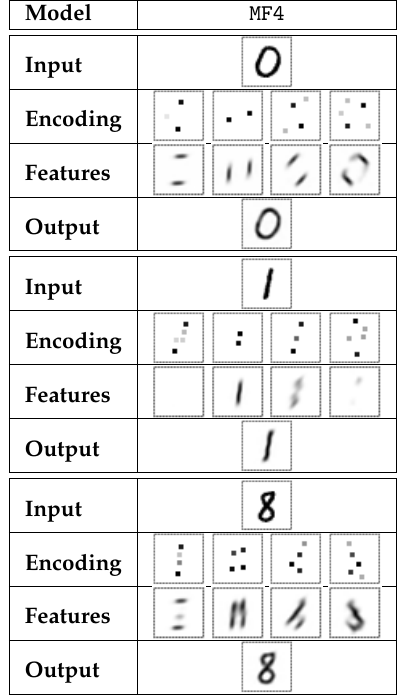
Figure 8. Sample encoding of selected digits performed by MF4 model. Apart from the input and output data and highly-sparse encoding (up to 5 non-zero elements in each encoding matrix), visualizations of single features are presented. Each visualization was acquired by decoding a synthetic code, where one of the visualized matrices was used, and all the other matrices were filled with